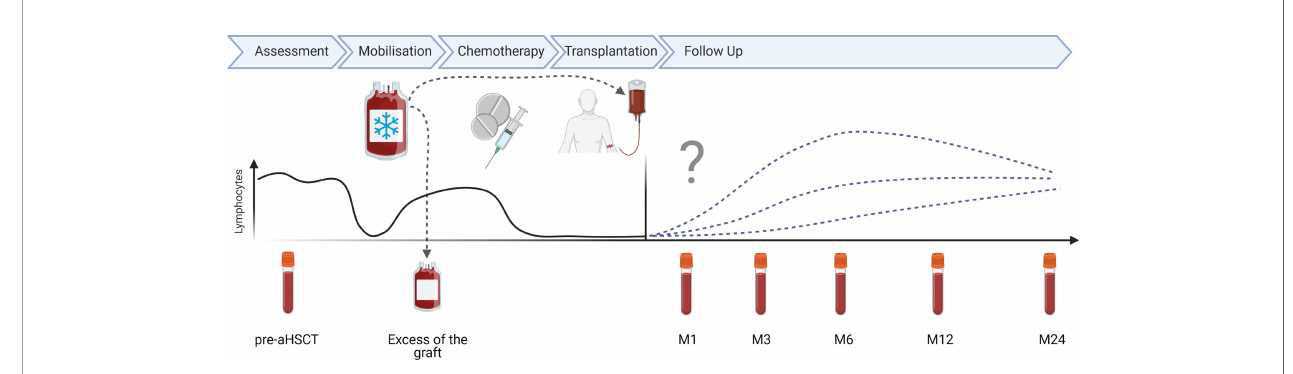
FIGURE 1 | aHSCT in MS treatment scheme: schematic overview of aHSCT in MS procedure and sampling time points in months